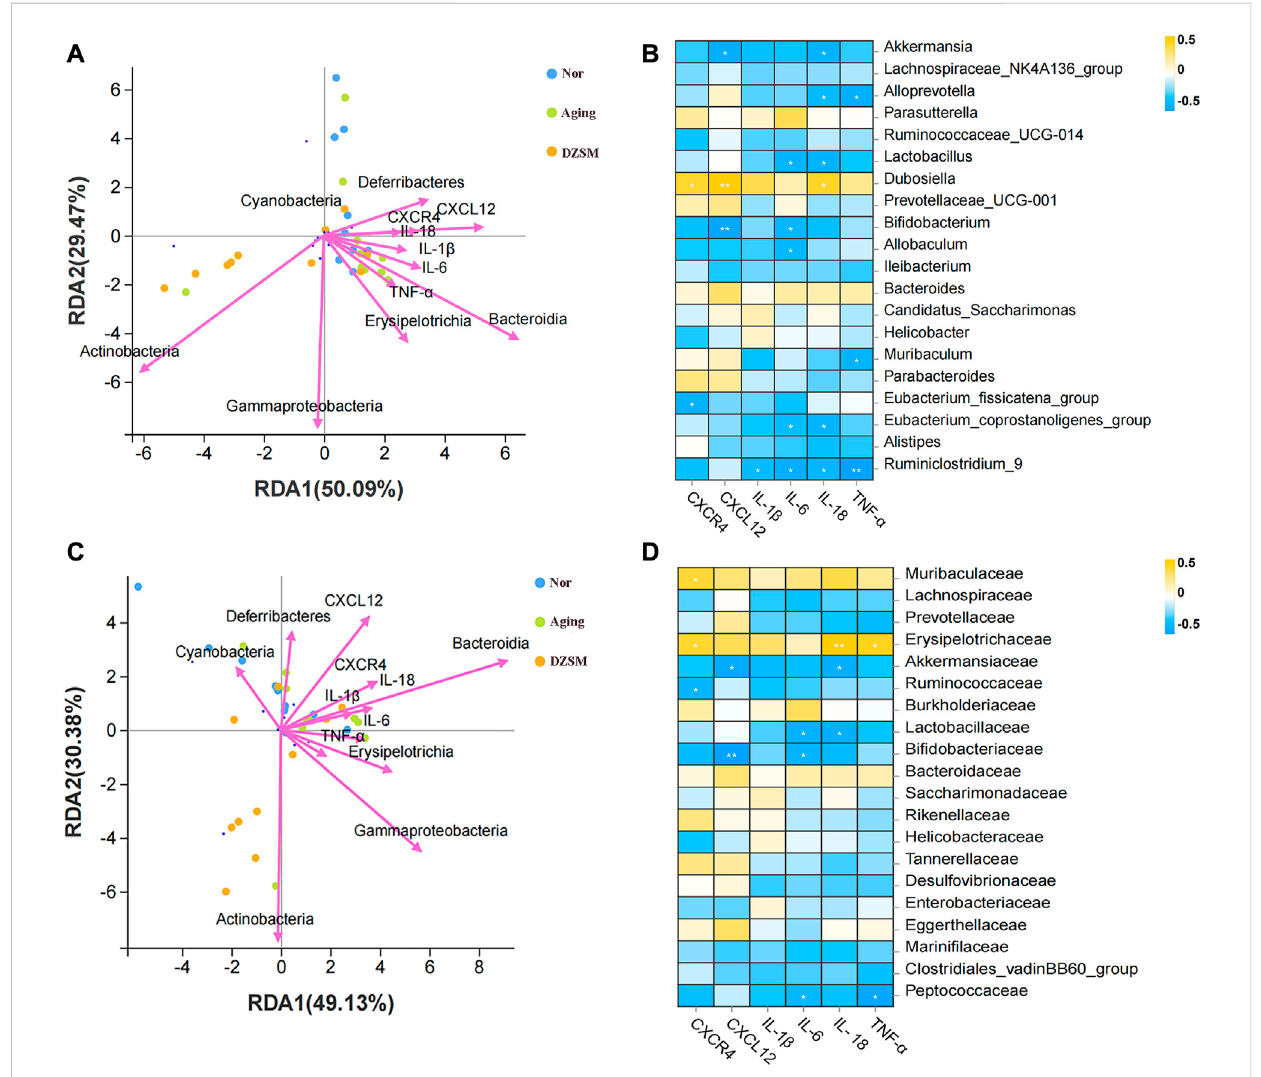
FIGURE 8 Relationship between the relative abundance of gut microbiota and key targets and pro-in fl ammatory cytokines. (A) Redundancy analysis (RDA) between microbes of the genus and key targets and pro-in fl ammatory cytokines; (B) Correlations between the microbes of the main genus and the key targets and pro-in fl ammatory cytokines; (C) Redundancy analysis (RDA) between the microbes of the family and key targets and pro-in fl ammatory cytokines; (D) Correlations between the microbes of the main family and the key targets and pro-in fl ammatory